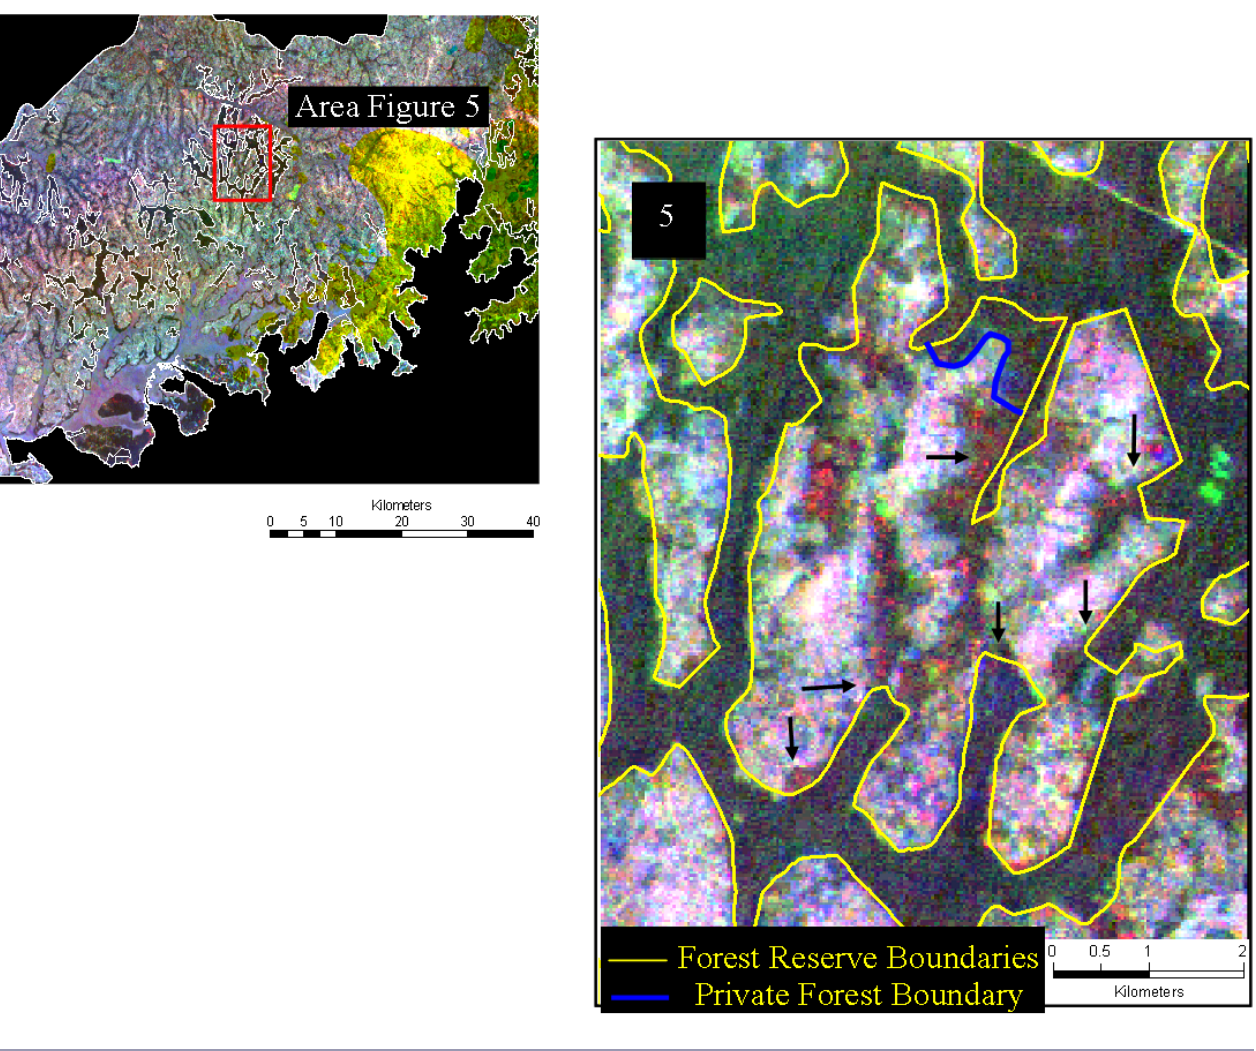
Fig. 5. Multitemporal composite illustrating respect for boundaries of the forest reserves. Red areas indicate a loss of forest cover between 1986 and 1995. Vector coverages delineating forest reserve boundaries extracted from a 1955 topographic map are shown by yellow lines. Black arrows point to areas with heavy forest clearing after January 1986 that proceeded up to, but not beyond, reserve boundaries. This composite was generated with one Landsat Multispectral Scanner image and two Landsat Thematic Mapper images, each acquired in 1974, 1986, and 1995, respectively. The composite was constructed by Nathan Vogt.